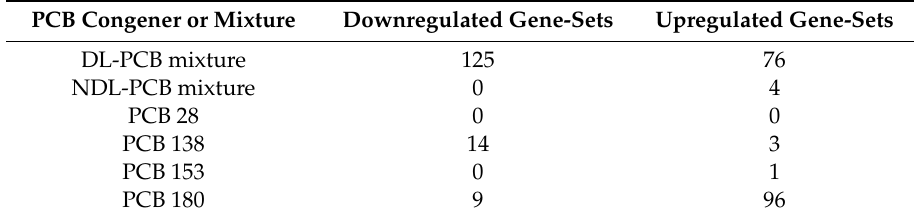
Table 5. Upregulated gene sets (GSEA).